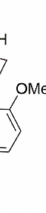
Figure 7. Structure of DQ-N